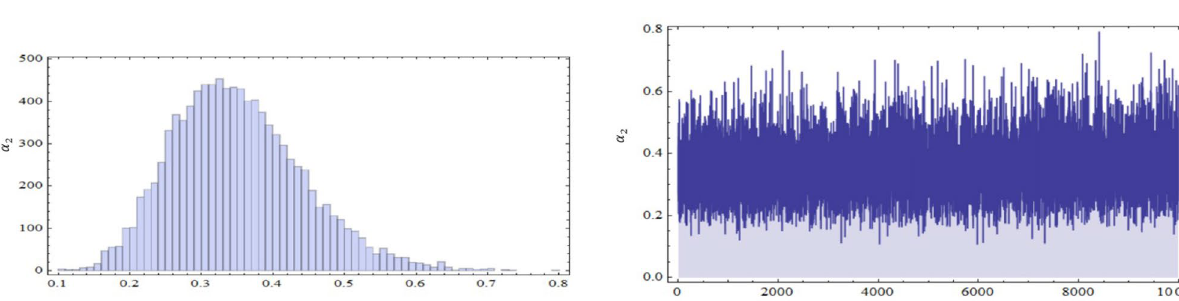
Figure 12. The posterior density function and the trace plots for the parameters β 1 .